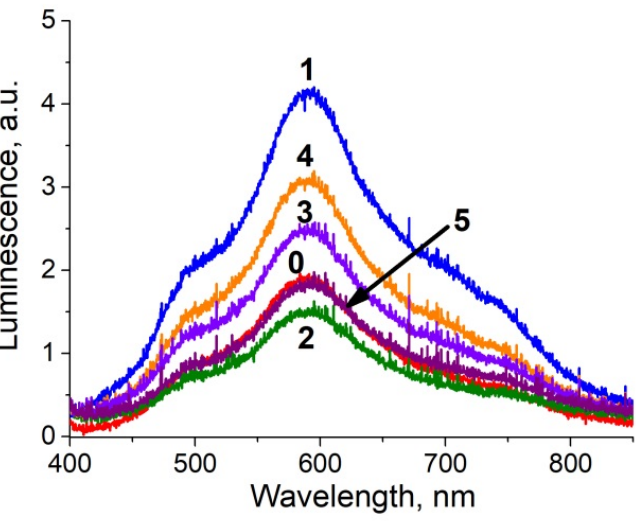
Figure 7. The luminescence spectra of Ag NPs-containing glass after exposure to different buffers. The excitation wavelength was 365 nm, the curves are marked according to the buffers ##, #0 corresponds to the untreated sample.